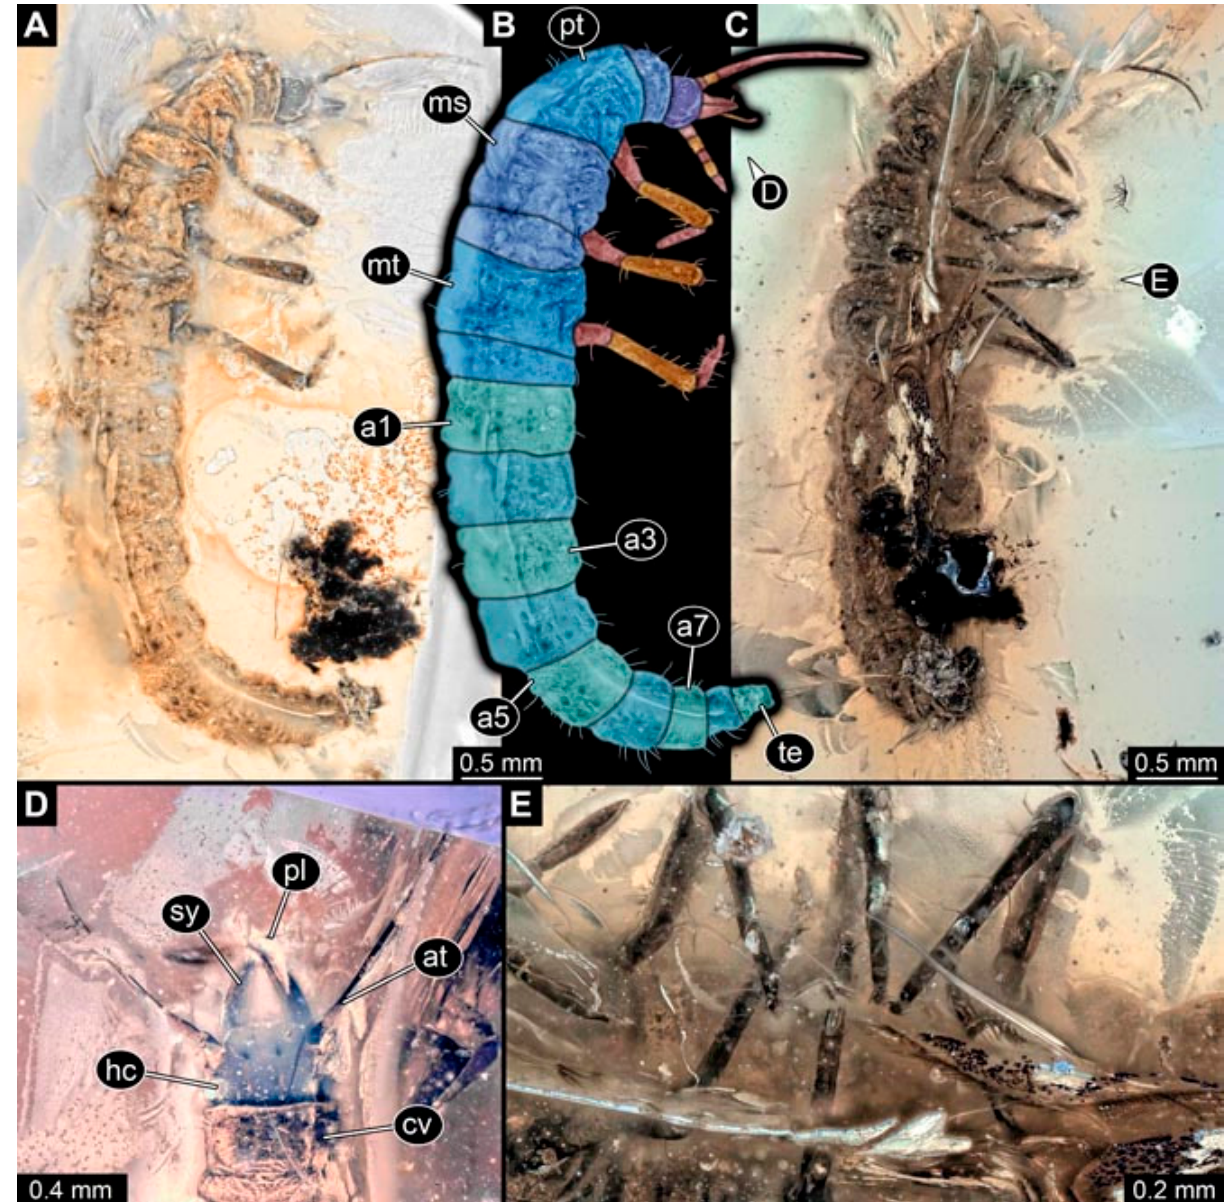
Figure 50. Specimen 4753 (CCHH 1786-3); Hemerobiidae; Baltic amber. ( A ) Dorsal view. ( B ) Dorsal view, colour-marked. ( C ) Ventral view. ( D ) Close-up of head capsule in dorsal view. ( E ) Close-up of trunk appendages. Abbreviations: a1–7 = abdomen segments 1–7; at = antenna; cv = cervix hc = head capsule; ms = mesothorax; mt = metathorax; pl = palp; pt = prothorax; sy = stylet; te = trunk end.